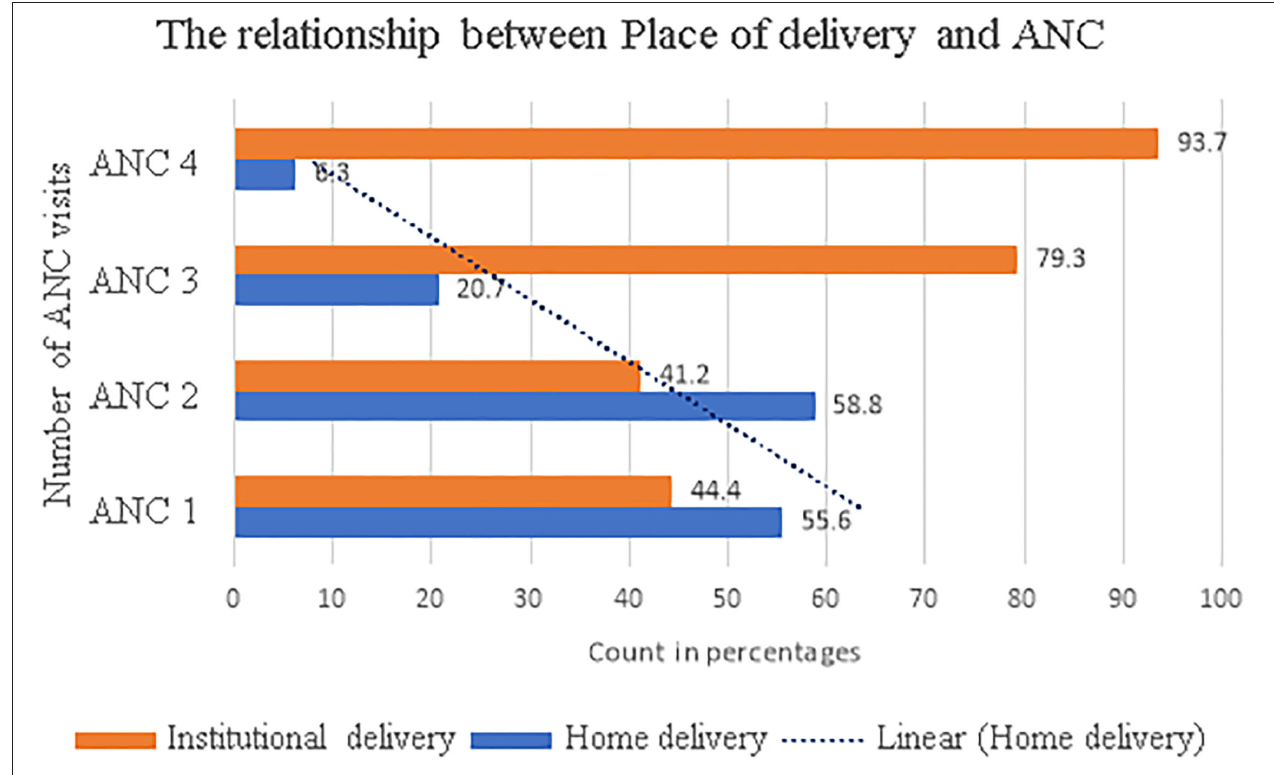
FIGURE 1 | The association between place of delivery and antenatal care (ANC) visit.